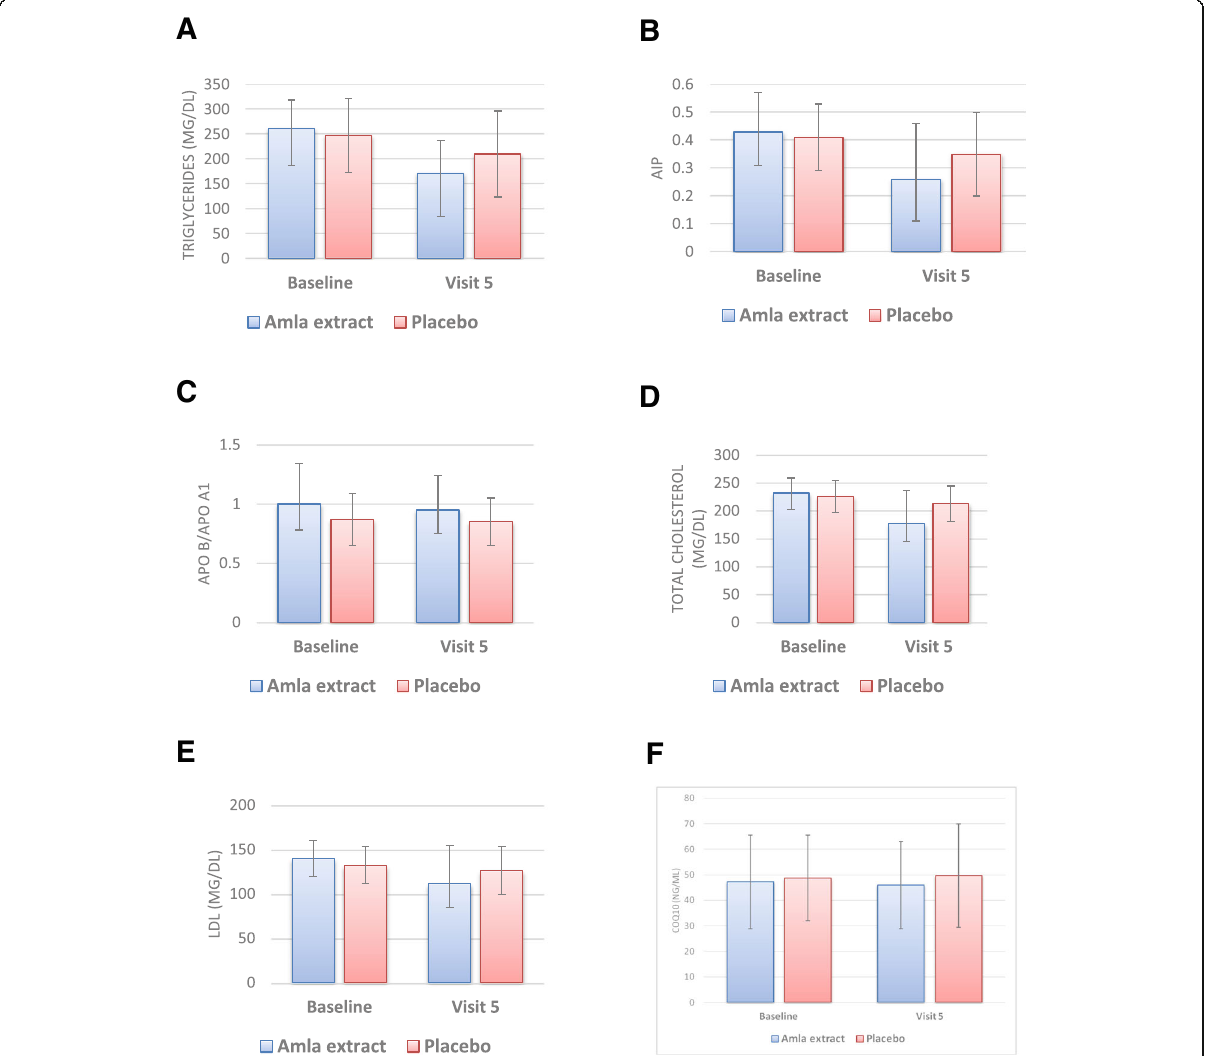
Fig. 3 ( a ) Triglyceride level in amla extract and placebo group ( p = 0.0003 between the groups); ( b ) Atherogenic index of plasma in amla extract and placebo group ( p = 0.0177 between the groups); ( c ) Ratio of Apo B to Apo A1 at baseline and visit 5 in amla extract and placebo group ( p = 0.0866 between the groups); ( d ) TC level at baseline and visit 5 in amla extract and placebo group ( p = 0.0003 between the groups); ( e ) LDL-C level at baseline and visit 5 in amla extract and placebo group ( p = 0.0064 between the groups); ( f ) CoQ10 level at baseline and visit 5 in amla extract and placebo group ( p = 0.4581 between the